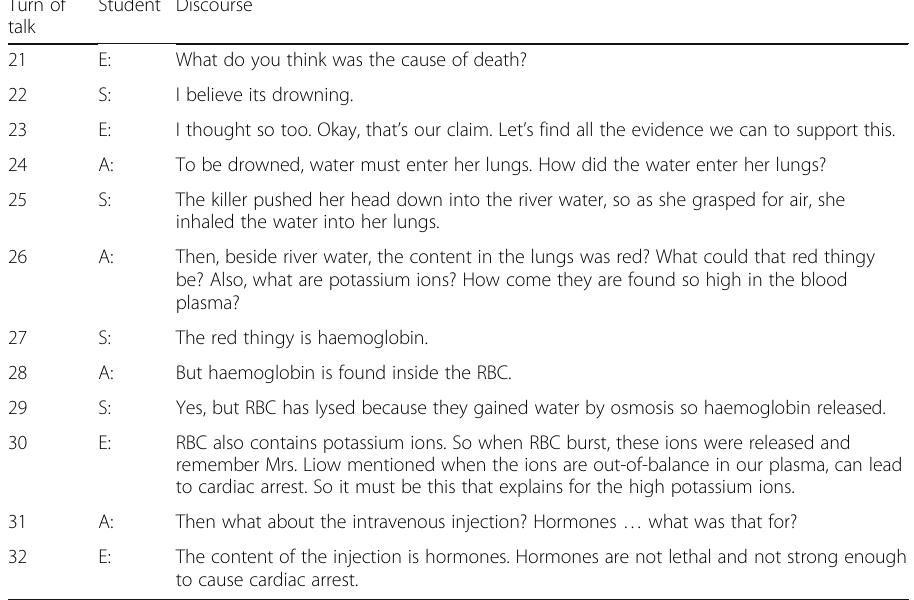
Table 10 Excerpt 4: A segment of discourse from group E ’ s discussion (lines 21 to 32) Turn of